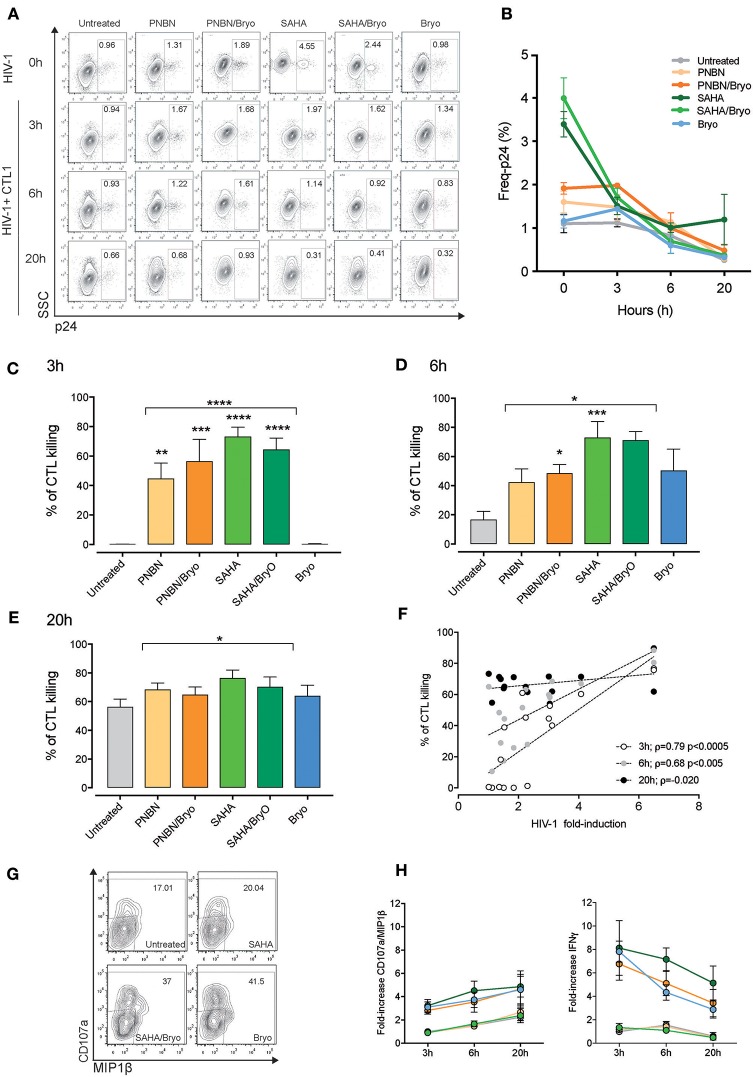
Kinetics of killing in response to HIV-1 reactivation by CTL. (A) Representative dot plots showing the percentages of intracellular p24 from HIV-1 RELI cells. The top line indicate the level of HIV-1 reactivation of RELI cells at baseline (0 h) in untreated and LRA-treated conditions and 3, 6, and 20 h after co-culture with CTL1 (B) Kinetics of elimination of HIV-1 reactivated by CTL. The graph shows the mean ± SEM of two independent experiments for CTL1. (C) Kinetics of killing of HIV-1 reactivated cells by CTLs at 3 h; (D) at 6 h; (E), and at 20 h after co-culture. Values in graphs C to E correspond to the mean ± SEM of three independent experiments for CTL1 and three independent experiments for CTL2 in replicates. The p-values were calculated using the unpaired t-test for comparisons between untreated cells and cells treated with HDACi (top line) and one-way ANOVA for multiple comparisons (asterisks above the bars). Only significant p-values are represented in the figure (*p < 0.05, **p < 0.005, ***p < 0.0005, ****p < 0.00005). (F) Correlation between HIV-1 fold induction and frequency of killing mediated by CTLs. The line indicates the fit of the data to a linear regression. The Spearman correlation coefficient (ρ) and the two-tailed p-value are indicated. The graph represents the frequency of killing from three independent experiments for CTL1 in replicates and three independent experiments for CTL2 in replicates. (G) Representative dot plots showing percentages of CD107a/MIP1β from CTL1 after co-culture with HIV-1 reactivated RELI cells. (H) Kinetics of CD107a/MIP1β and IFNγ secretion from CTLs after co-culture with HIV-1 reactivated RELI cells. The graphs show the mean ± SEM of two independent experiments for CTL1 and two independent experiments for CTL2 in replicates.